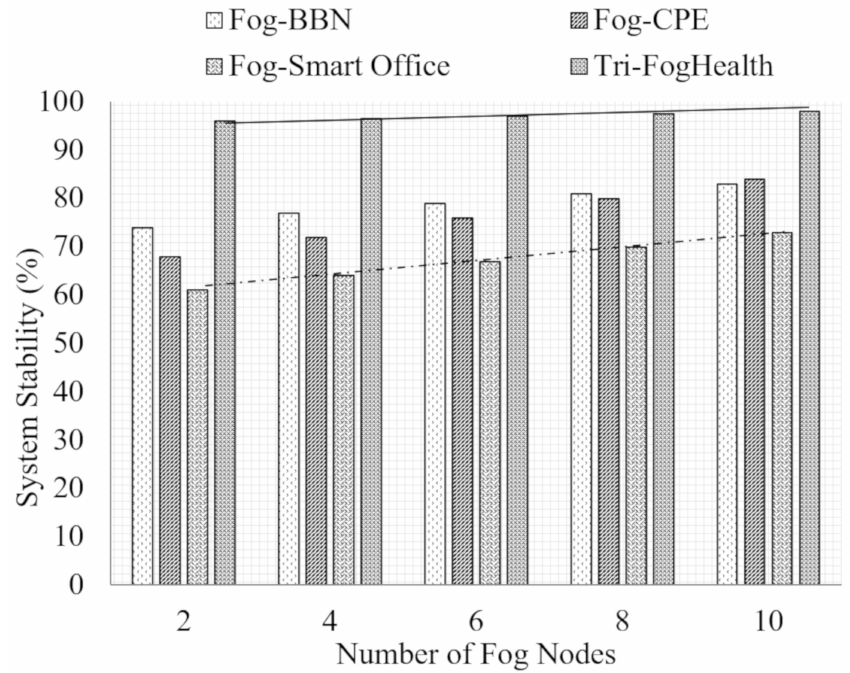
Figure 14. Comparison of System Stability.